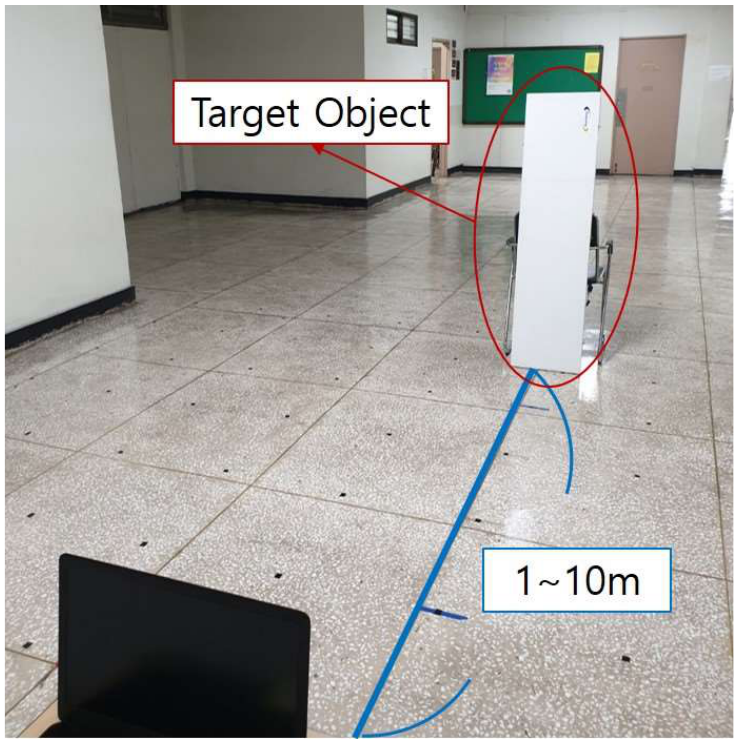
Figure 2. Experiment environment and target object used in experiments. Information 2021 , 12 , x FOR PEER REVIEW